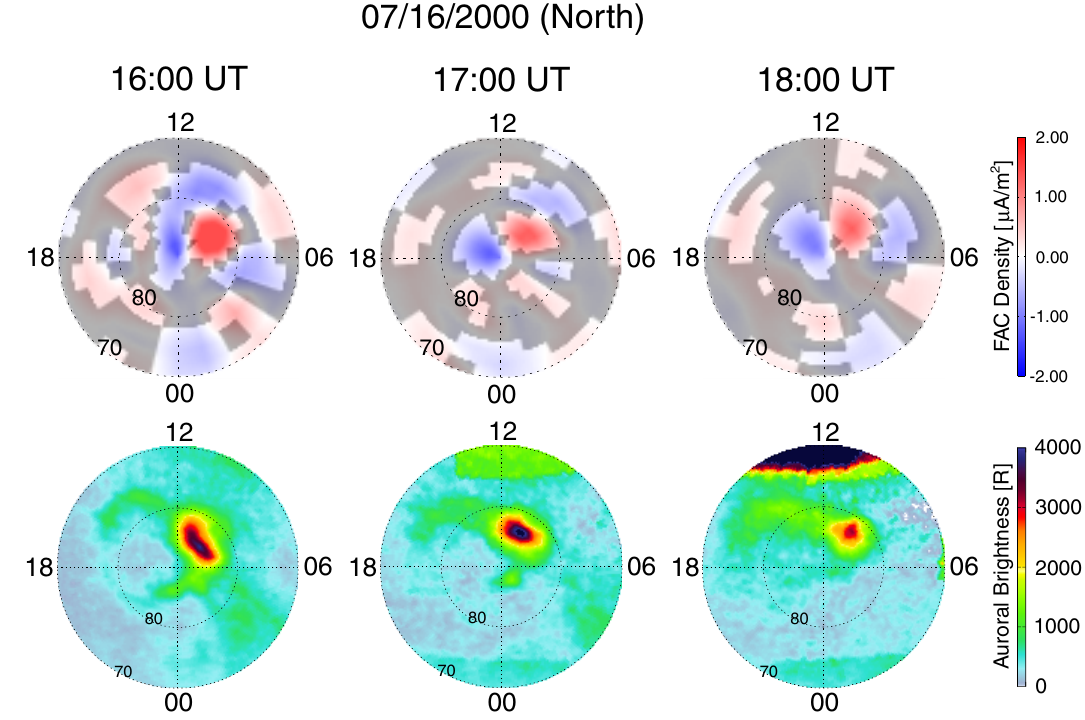
Fig. 5. Birkeland currents (upper panels) and one-hour averaged WIC auroral emissions (bottom panels) on 16 July 2000, from 16:00 UT to 19:00 UT in AACGM MLT-MLAT